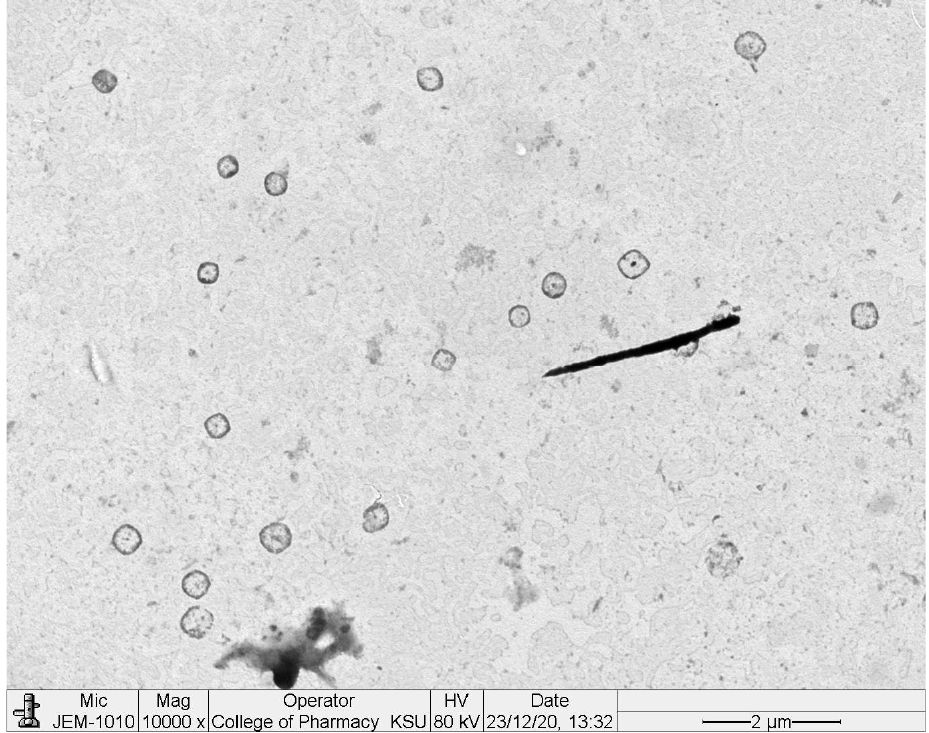
Figure 8. TEM images of chitosan-coated BGT-loaded NSPs.